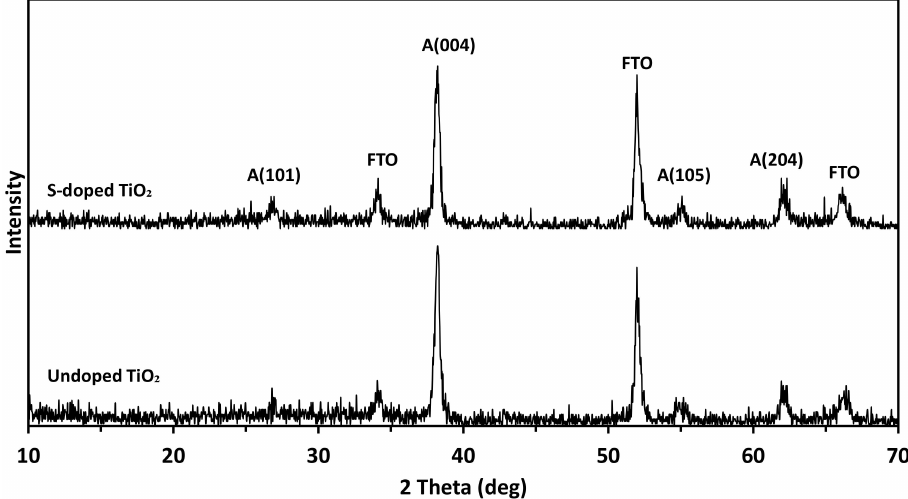
Figure 2. XRD diffractograms of the un-doped and S-doped TiO 2 photo-anode thin films.